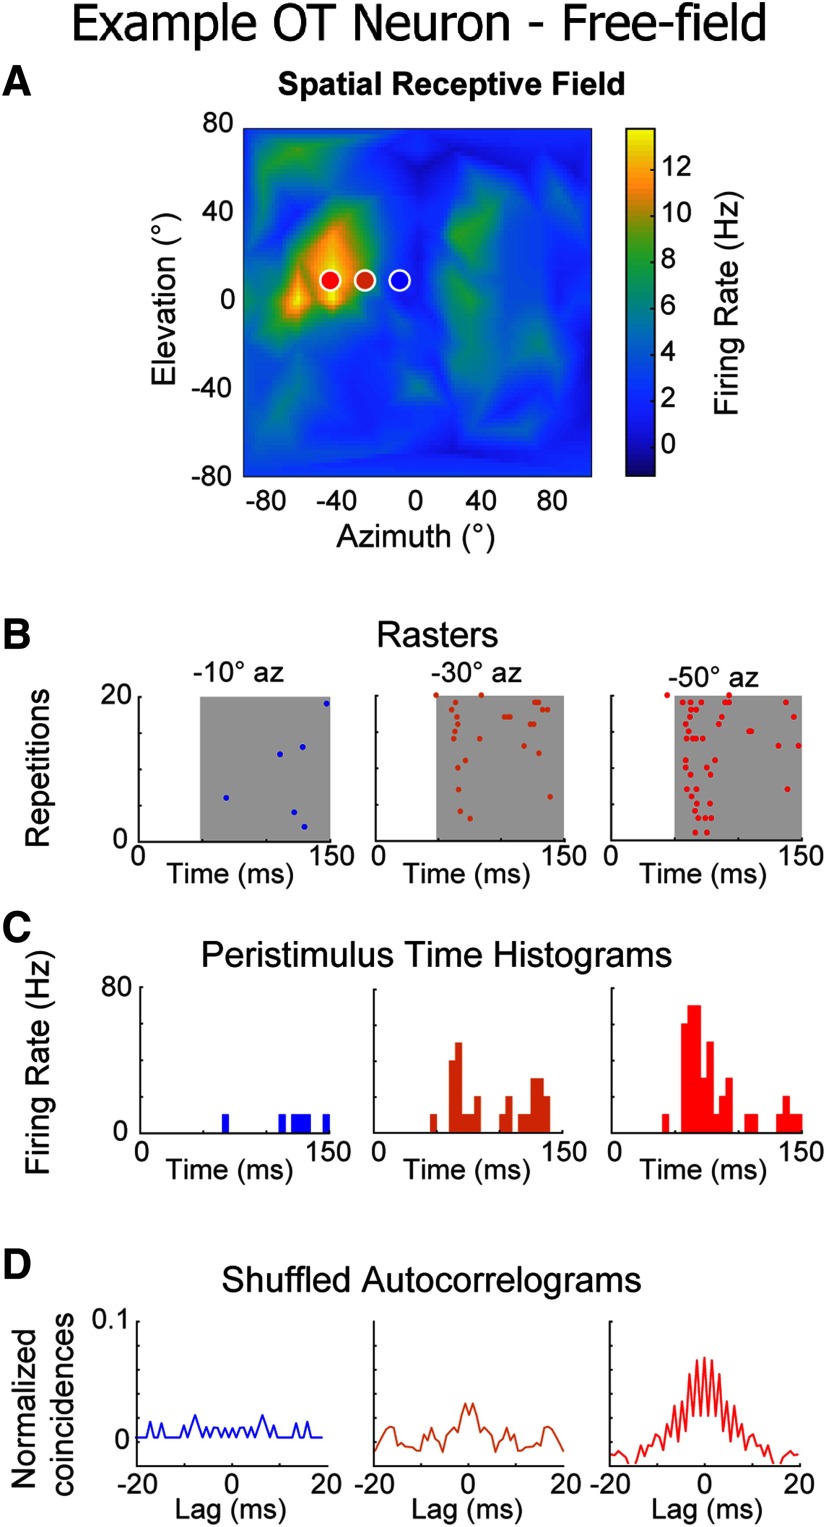
Reproducibility in OT to sounds from varying positions in auditory space. A, Example SpRF of an OT neuron. Colored dots indicate responses displayed in B–D. B, Example spiking raster plots at varying azimuth from the cell shown in A. Gray background represents region of stimulation used for SAC, distance, and synchrony analysis. C, Peristimulus time histograms generated from the raster plots in B (5-ms bin size). D, SACs generated from the rasters in B.